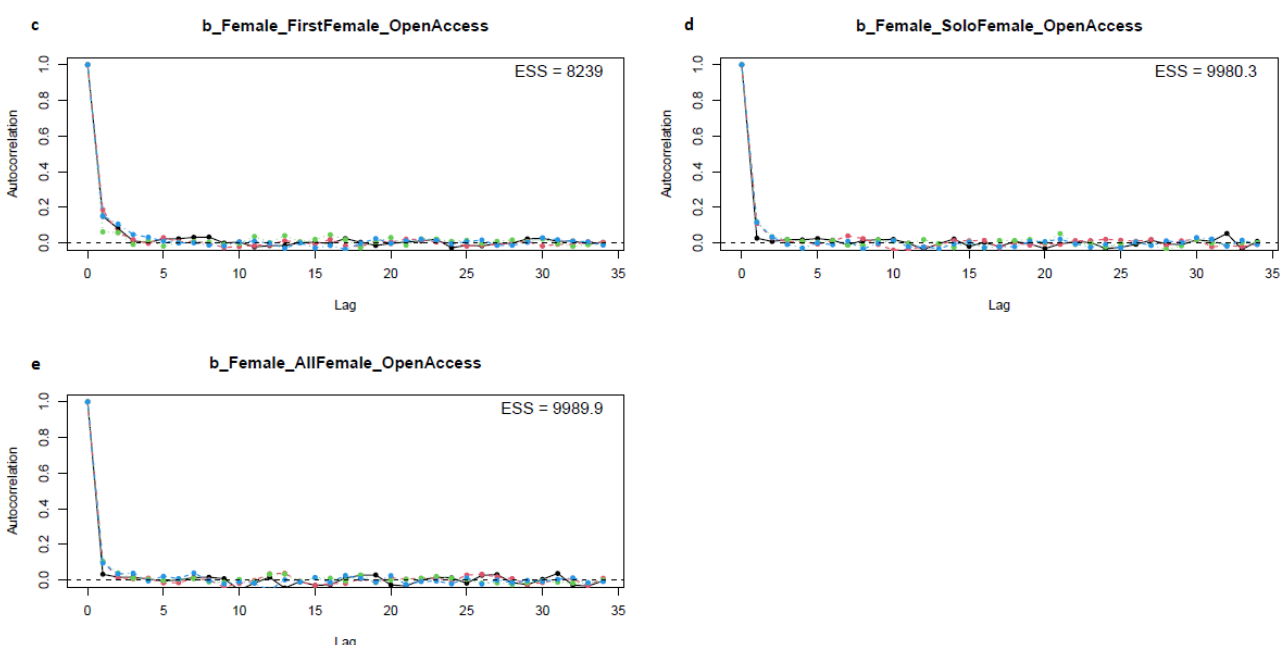
Figure A2. Autocorrelation plots of parameters: ( a ) Constant ; ( b ) Female ; ( c ) Female × FirstFemale ; ( d ) Female × SoloFemale ; ( e ) Female × AllFemale . Table A1. Probabilities of Gold Access publishing by gender-based authorship structures.